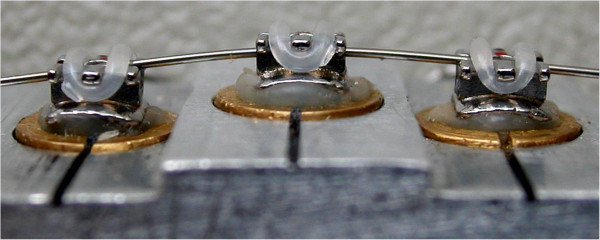
Stainless steel support of the horizontal bracket displacement experimental model. The central bracket is 1 mm buccally displaced relative to the adjacent brackets.